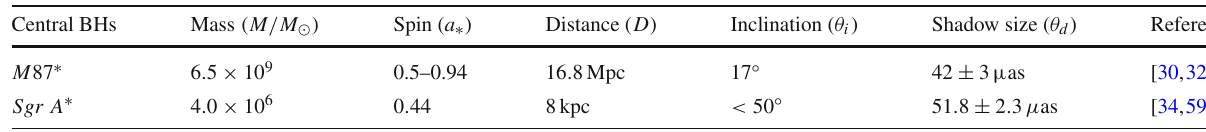
Table 1 EHT observational data for M 87 ∗ and Sgr A ∗ shadows